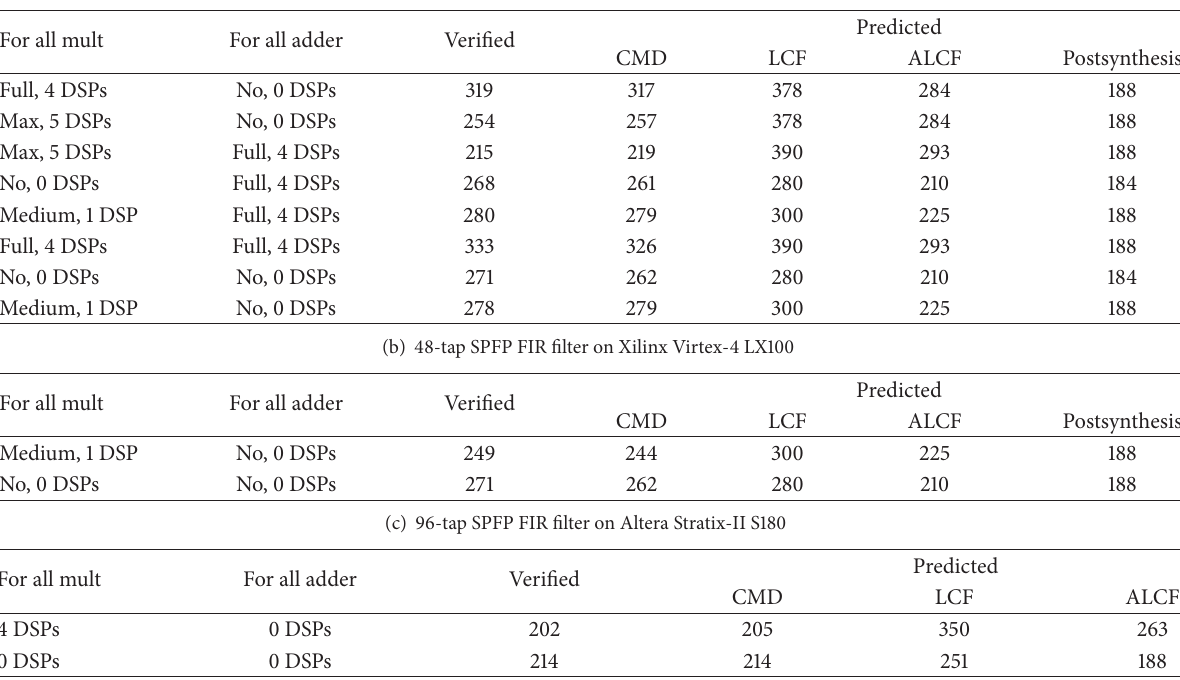
Table 4: Core-level DSE example for SPFP FIR filters